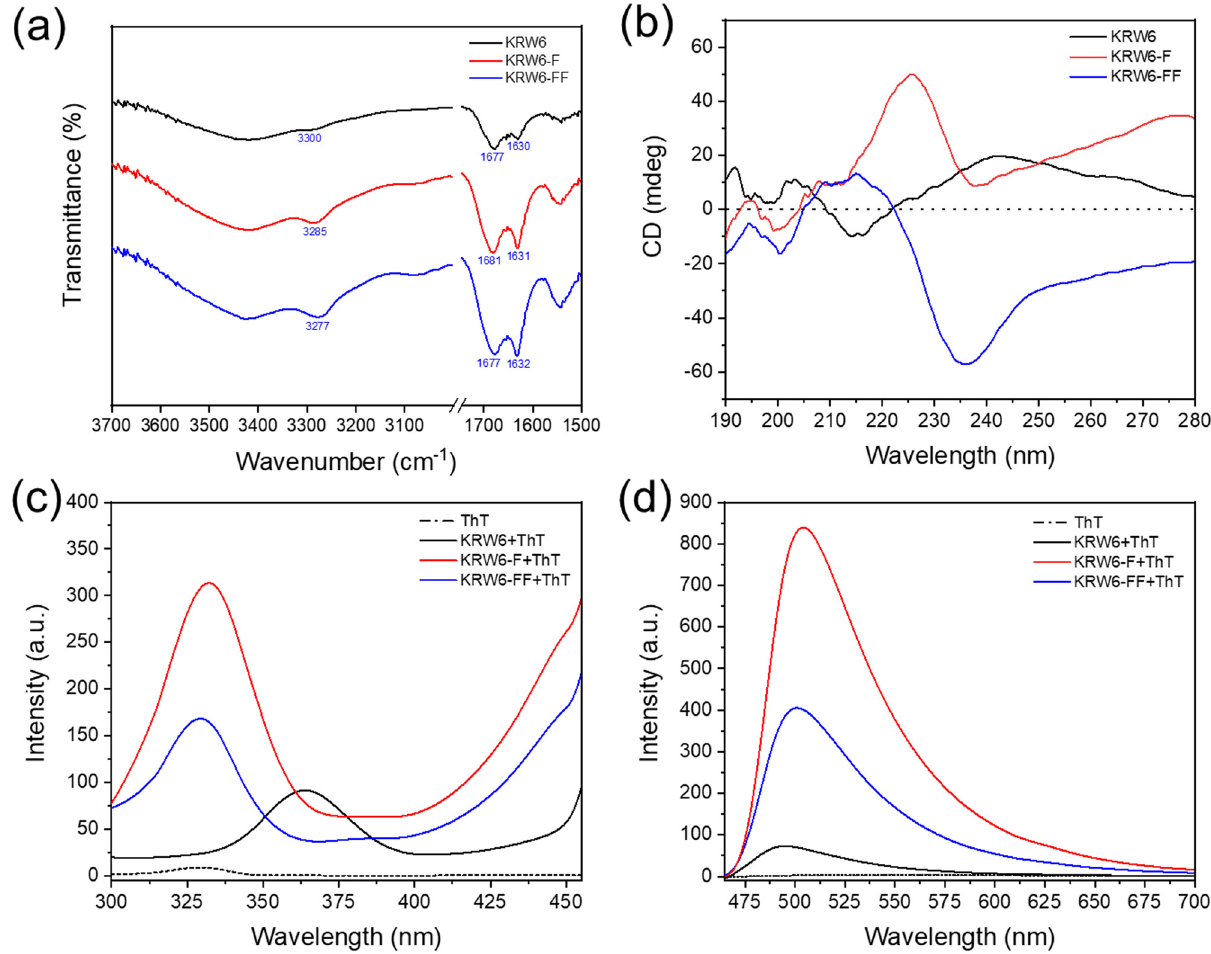
Figure 2: ( a ) FTIR and ( b ) CD spectra of KRW6, KRW6 - F, and KRW6 - FF peptide self - assemblies; ( c ) fl uorescence excitation spectra and ( d ) fl uorescence emission of ThT solution ( 1 mg · mL − 1 ) and KRW6, KRW6 - F, and KRW6 - FF peptide self - assemblies dyed with ThT with λ = 482 nm and λ = 450 nm, em ex